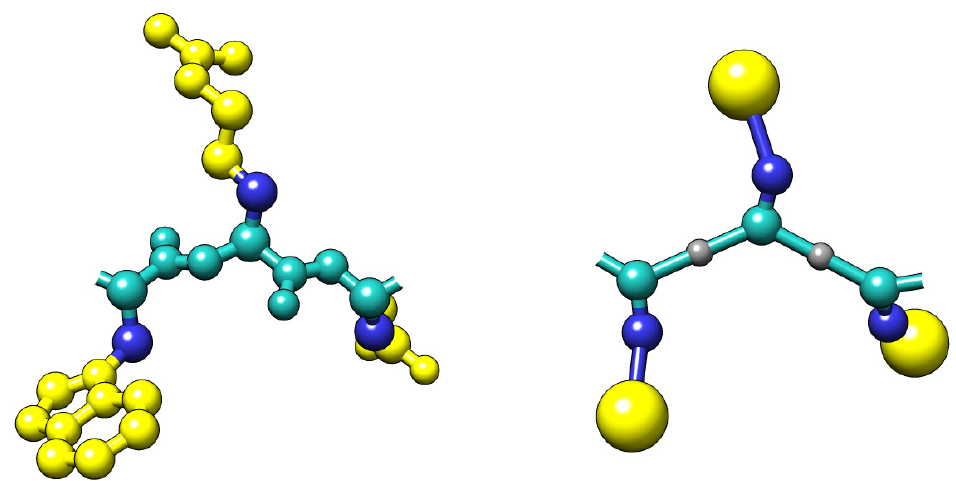
Figure 6. Comparison of the all-atom ( left ) and the CABS coarse-grained model representation ( right ) for an example tripeptide. In the CABS model, protein residues are represented using C-alpha, C-beta, united side-chain atom, and the peptide bond center [29].